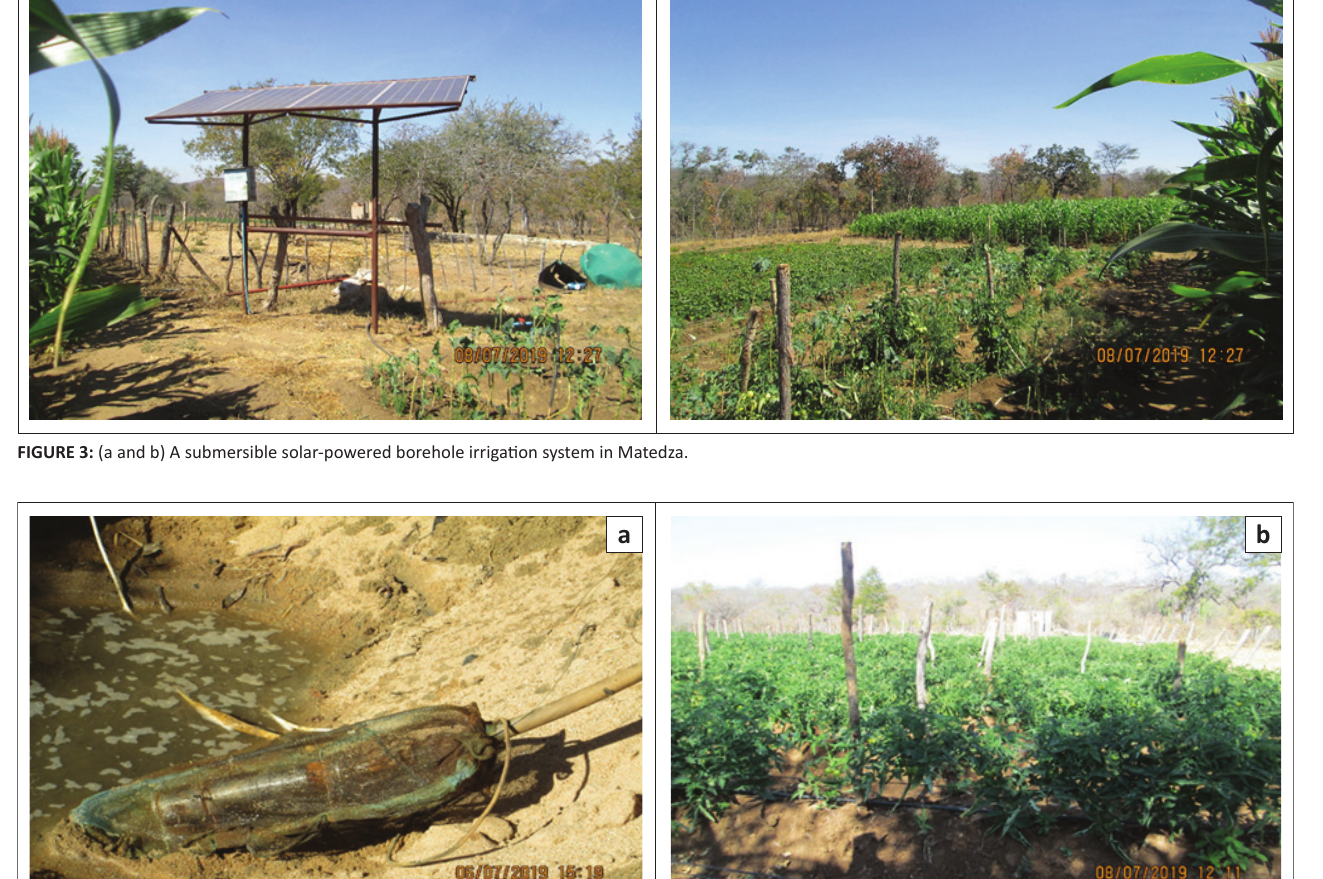
FIGURE 4: (a and b) A submersible solar-powered river waterhole irrigation system in Matedza village.